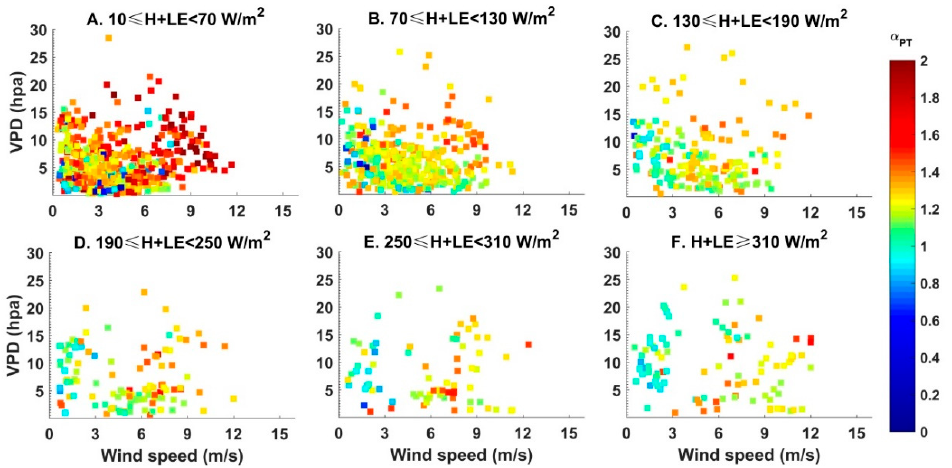
Figure 9. Distributions of 30 min scale α with respect to VPD and wind speed under a range of available energy conditions during high ‐ water period.